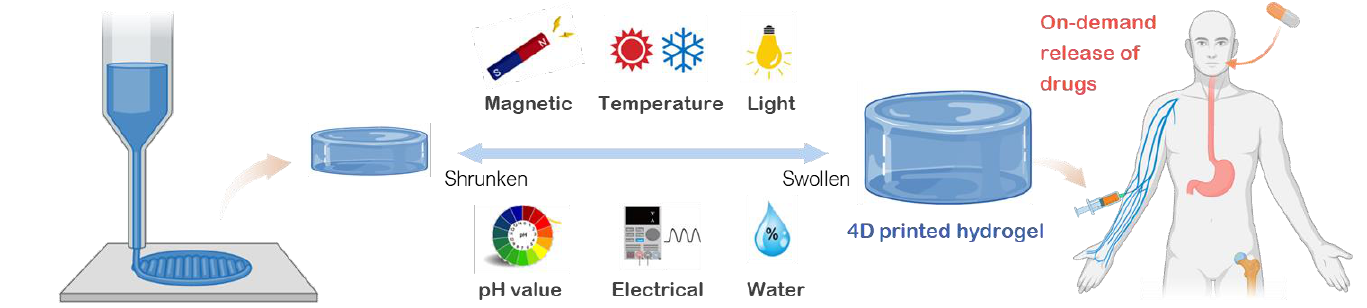
Figure 2. An overview of stimuli-responsive hydrogels and their applications for 4D printed drug delivery systems. Created with BioRender.com. Adapted with permission from [2]. Copyright © 2019 Springer Nature.